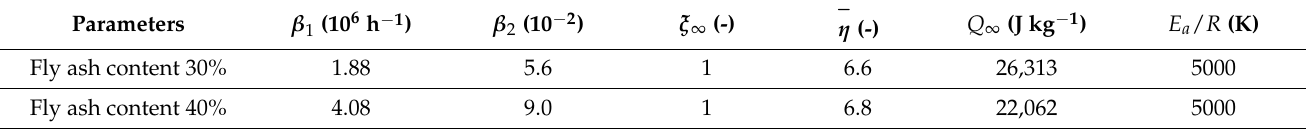
Table 4. Parameters describing the cement hydration properties.